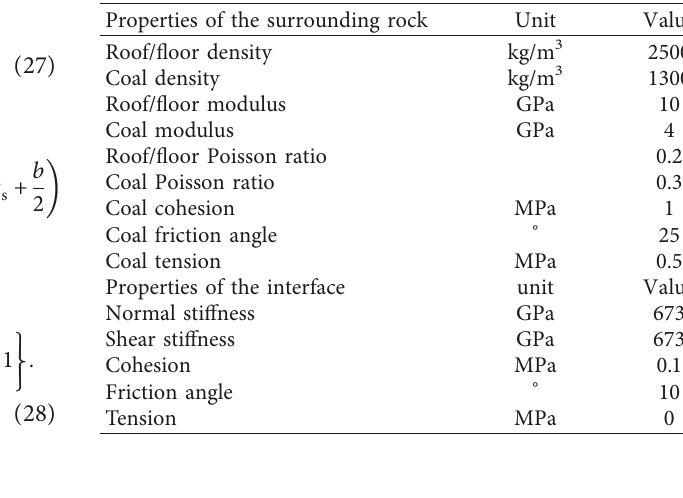
Table 2: Properties of the surrounding rock and the interface. Properties of the surrounding